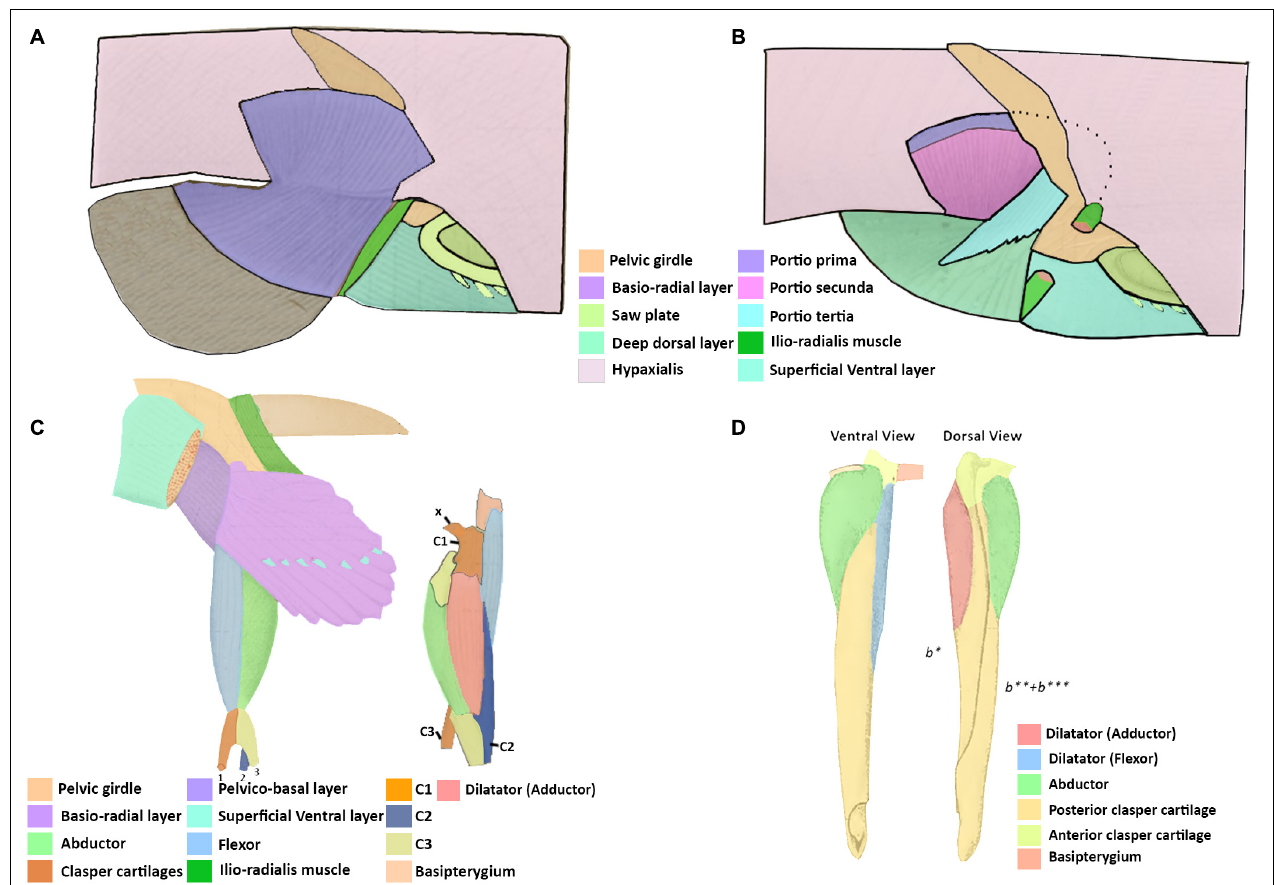
FIGURE 7 | Illustrations adapted from Davidoff (1879) of the pelvic and clasper musculature of Chimaera monstrosa and from Jungersen (1899) of the clasper musculature of Callorhynchus antarcticus . (A) Right lateral view of the superficial dorsal pelvic musculature of C. monstrosa , (B) same view of the deep dorsal pelvic musculature of C. monstrosa , (C) ventral view of left pelvic musculature and lateral left view of clasper musculature of C. monstrosa , (D) ventral and dorsal views of the right pelvic clasper of C. antarcticus . x, ventral process; C1, first cartilage; C2, second cartilage; C3, third cartilage; b ∗ , first cartilage; b ∗∗ , second cartilage; b ∗∗∗ , third